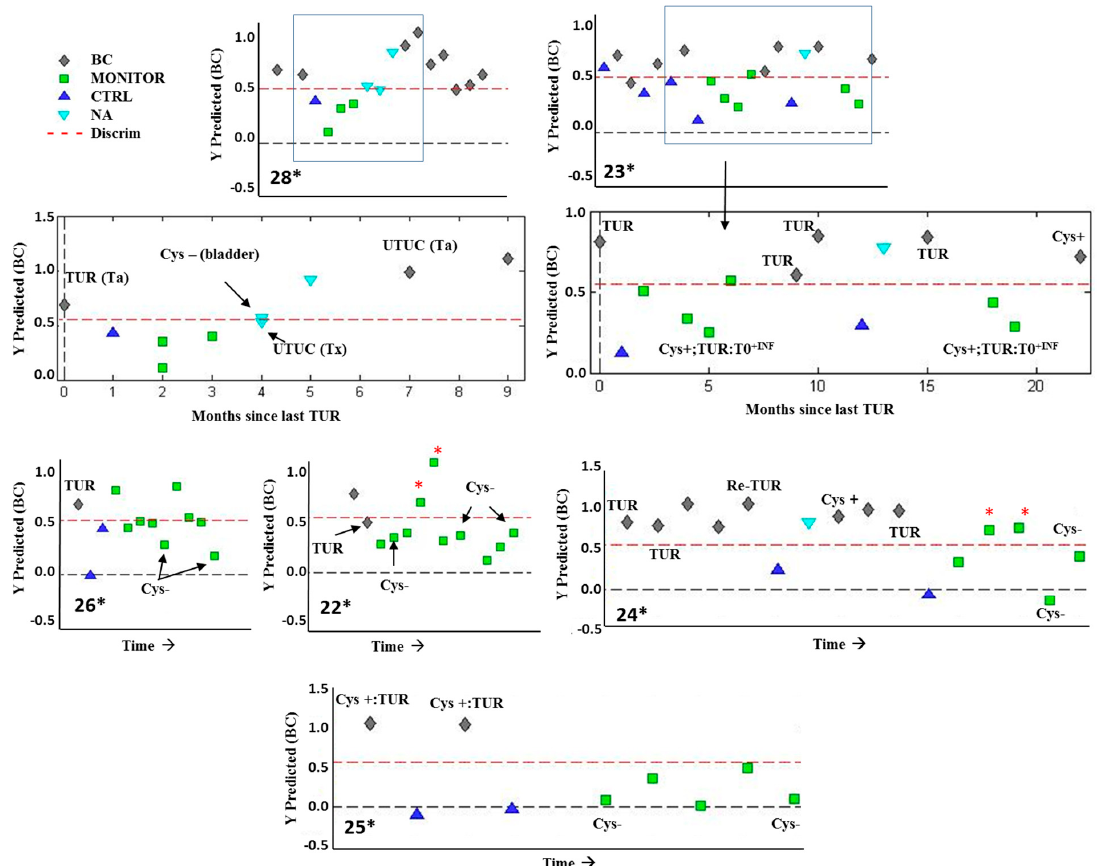
Figure 5. Analysis of longitudinal metabolic trajectories after transurethral resection (TUR) of BC. Predicted y Partial Least Square Discriminant Analysis (PLS-DA) values in six patients during the follow-up period. Note: (*) indicates a MONITOR sample showing an inconsistent trajectory; (Cys + or Cys − ) indicates a positive or negative cystoscopy, respectively; (T0) indicates tumor absence by PA evaluation; (Tx) indicates that the pathologist did not confirm the presence of a tumor; (INF) indicates cystitis; (UTUC) means upper tract urothelial carcinoma.